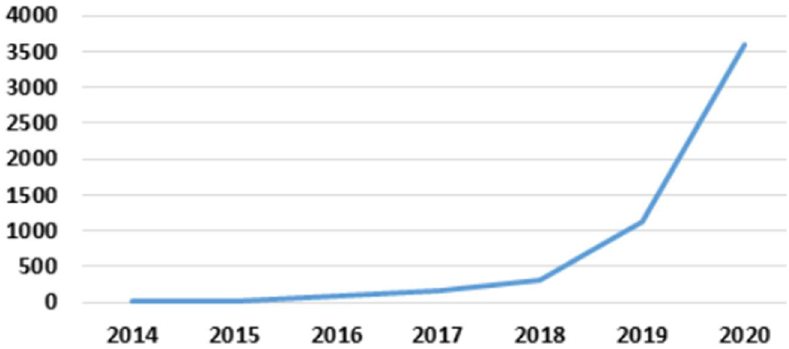
Figure 4. Number of PV installations connected in the City of Kraków, based on data from Tauron Dystrybucja Co. [55].